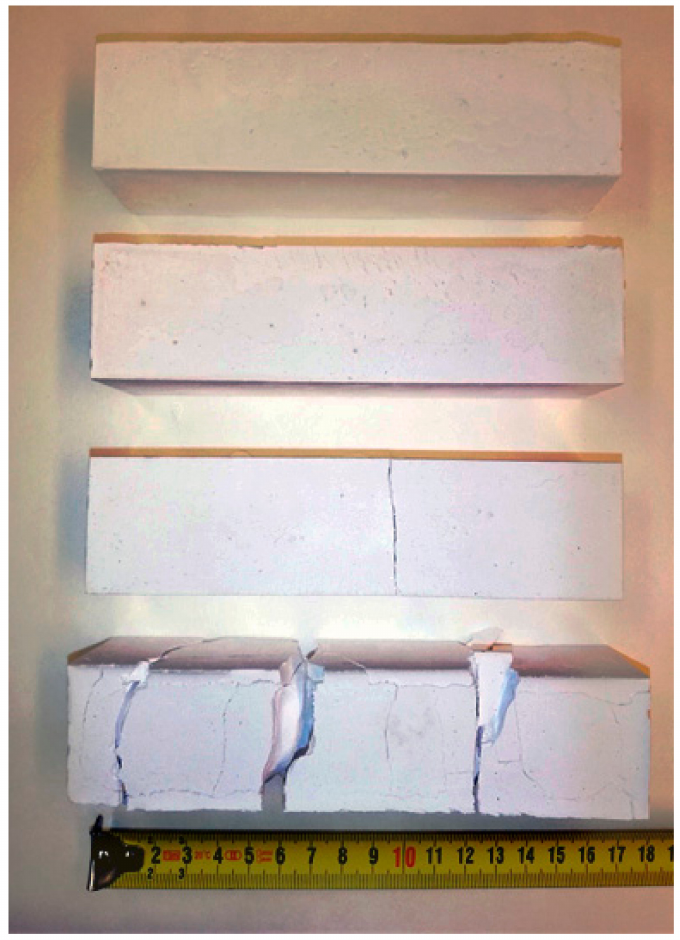
Figure 10. The failure of MOC samples after exposure to elevated temperatures; from top: MOC 20, MOC 150, MOC 250, and MOC